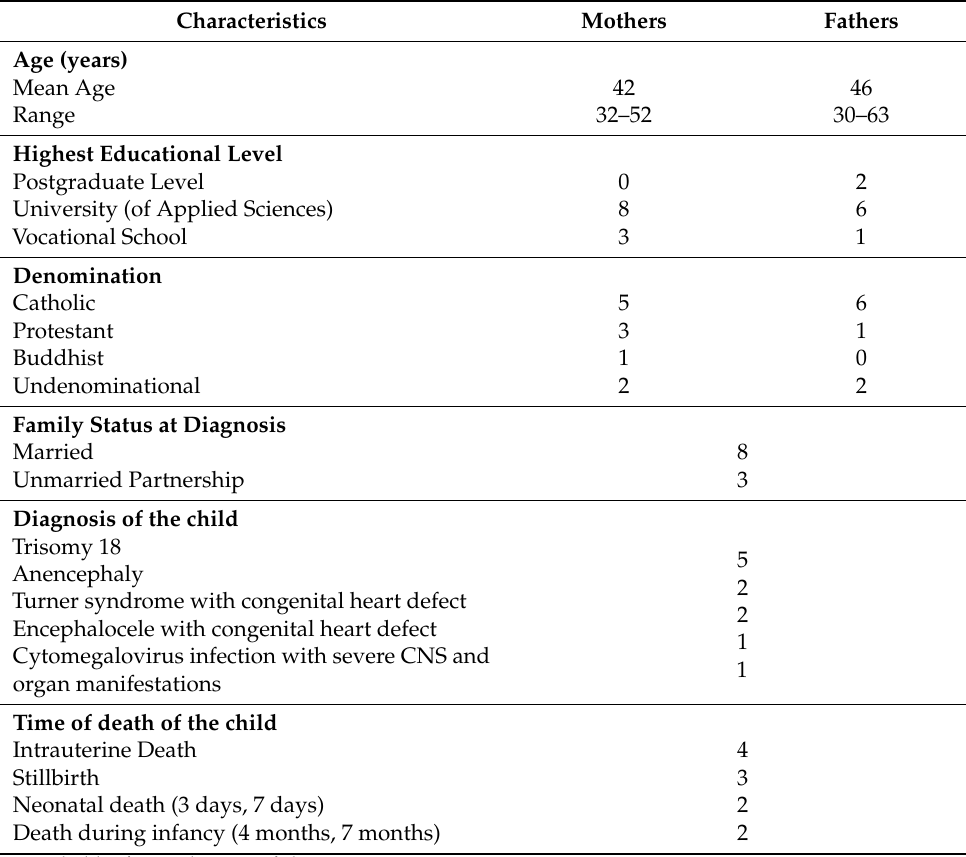
Table 1. Demographic characteristics of participants ( n =